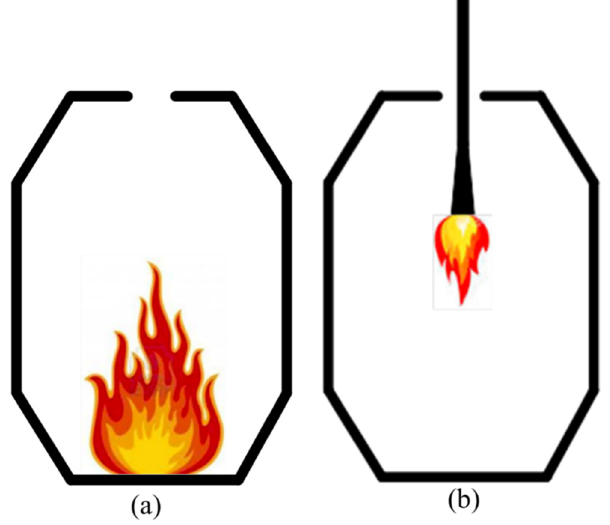
Figure 1. Showing two preheating scenarios: ( a ) conventional (injection of fuels through the bottom tuyeres), ( b ) proposed preheating approach (injection of fuels through a top burner).